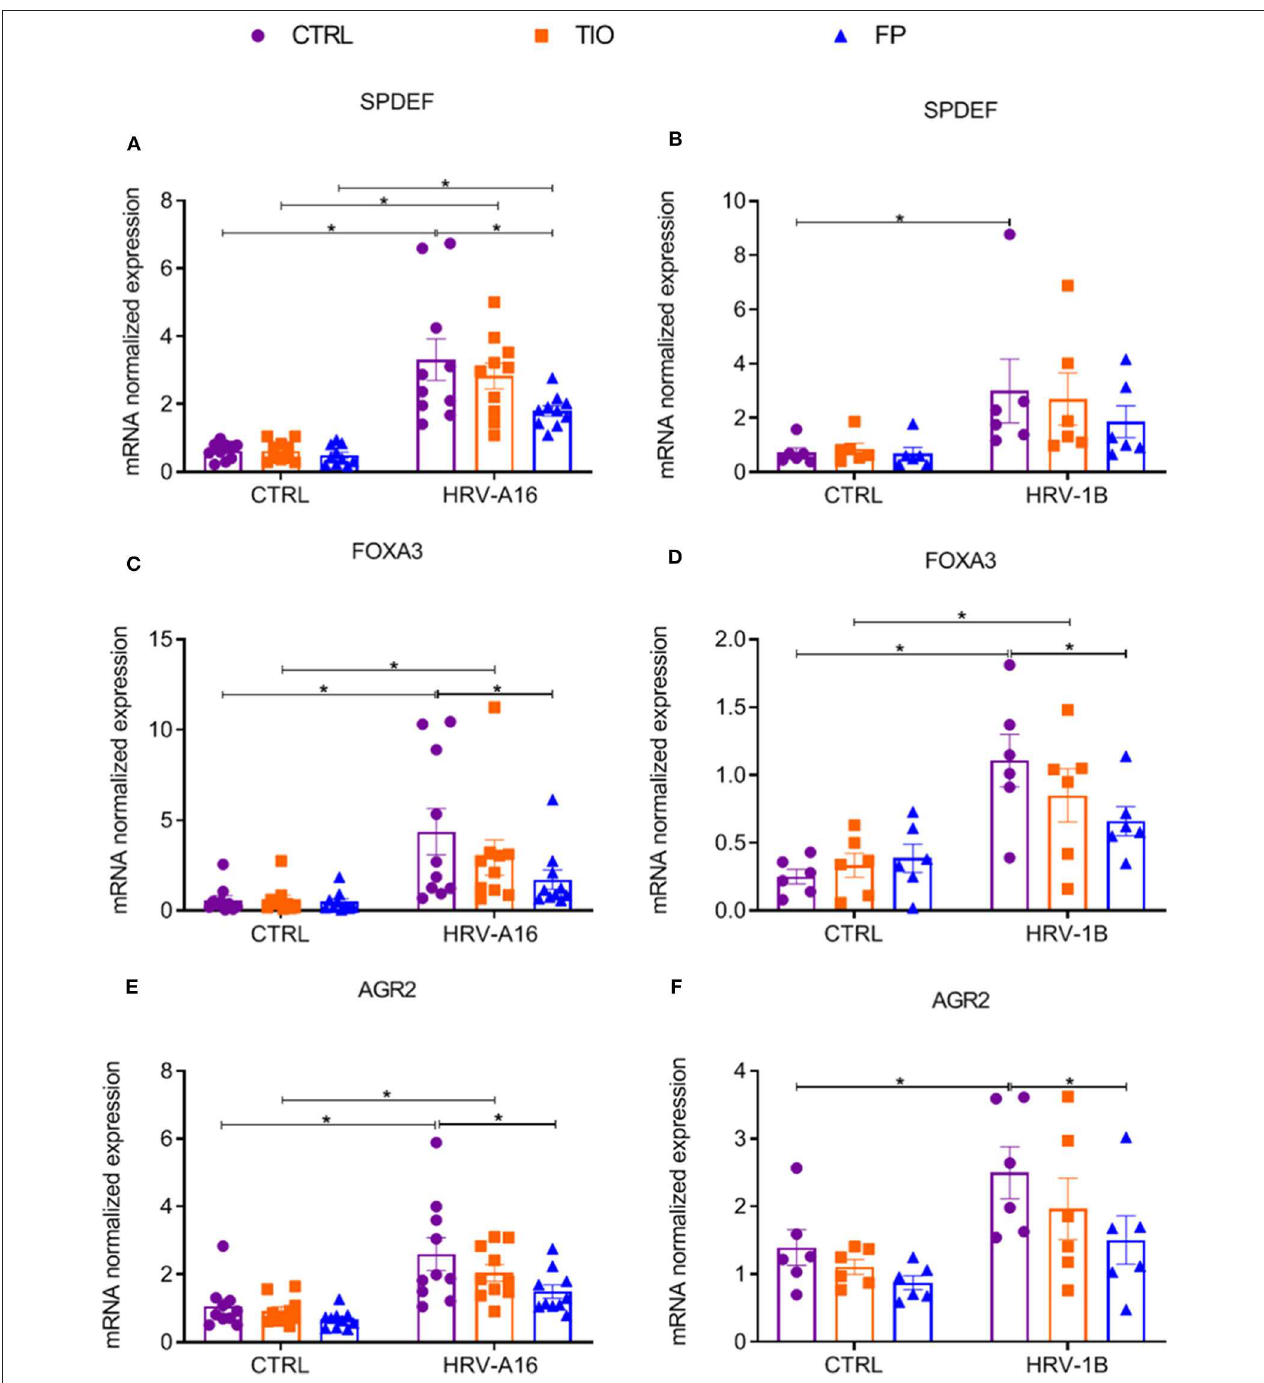
FIGURE 7 | Modulation of fluticasone on SPDEF-regulated genes in ALI-PBEC. ALI-PBEC were pre-treated with tiotropium or fluticasone and infected with HRV-A16 (MOI 5). Cells were harvested at 48h after infection. The gene expression of SPDEF (A,B) , FOXA3 (C,D) and AGR2 (E,F) were measured by real-time PCR. Data are shown as target gene expression normalized for RPL13A and ATP5B. Data are mean values ± SEM. n = 10 or 6 independent donors. Analysis of differences was conducted by two-way ANOVA with a Tukey post-hoc test Significant differences are indicated by * P < 0.05 compared with control or HRV-A16 group.